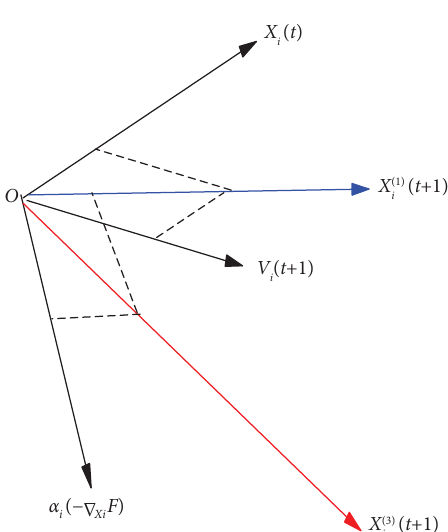
Figure 1: Diferences between the two